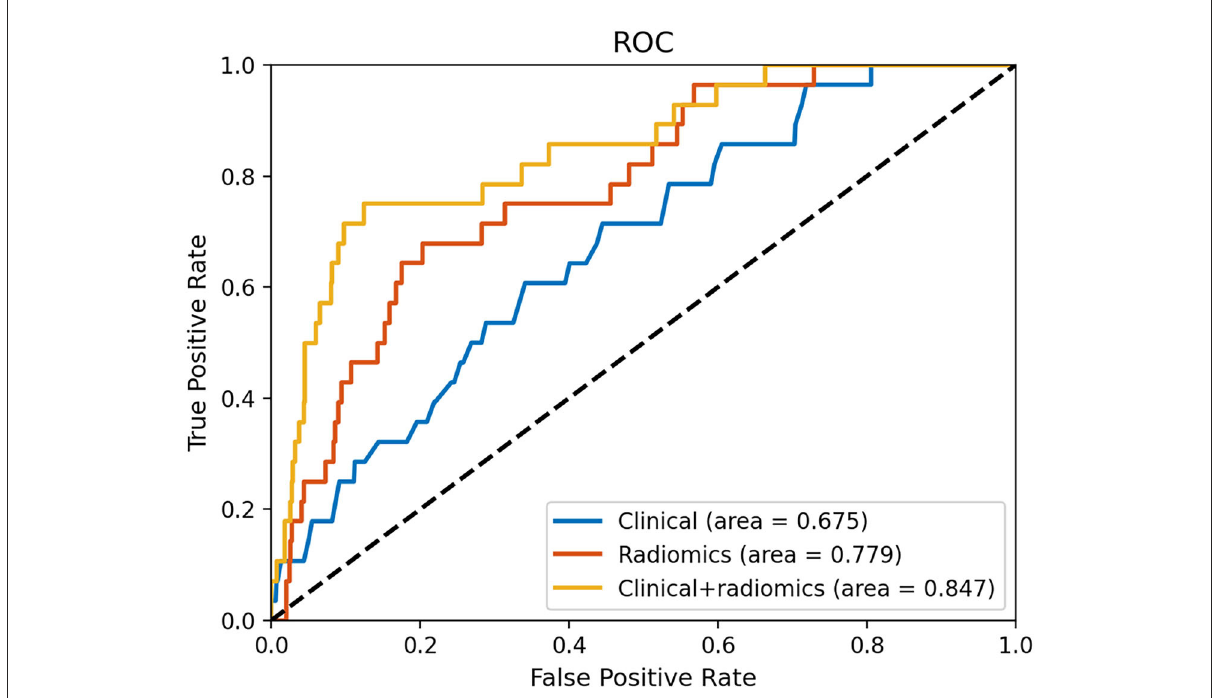
FIGURE4 Receiver operating characteristic curves based on the clinical characteristics and radiomics.